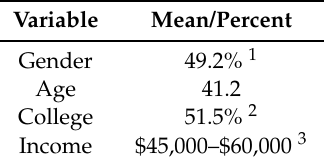
Table 3. Summary Statistics of Household Survey